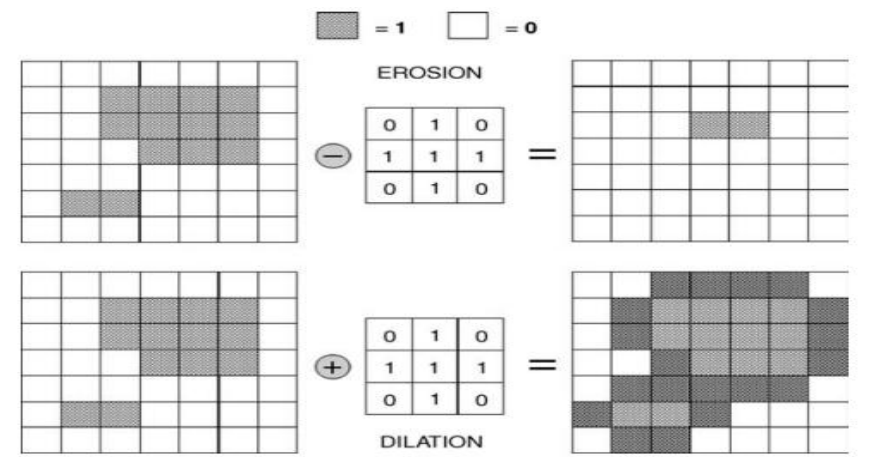
Fig.2: The erosion and dilation of a simple binary image